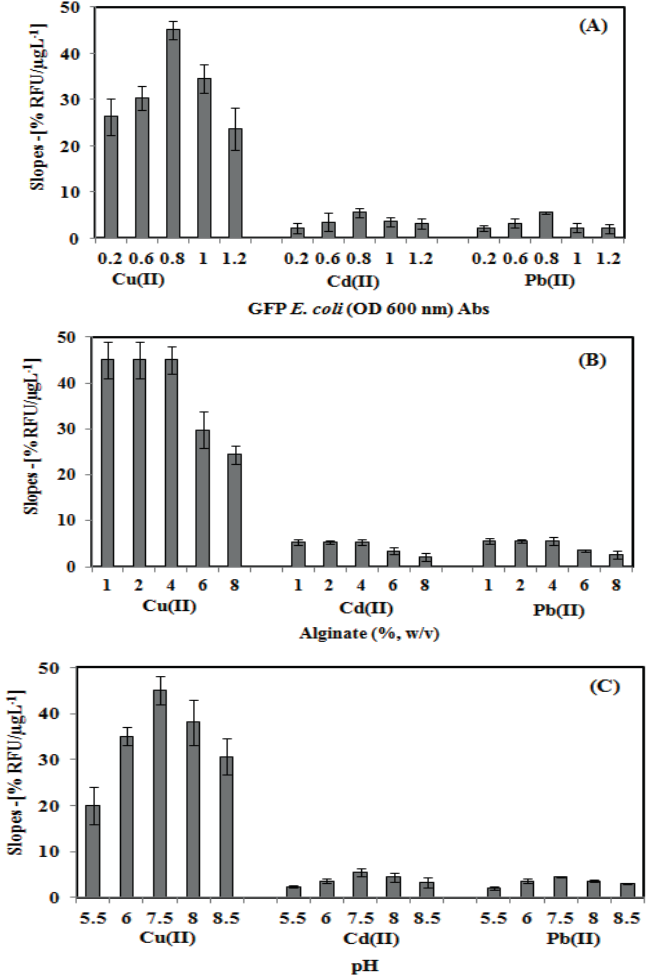
Figure 3. Effect of GFP E. coli cell loading ( A ), alginate concentration ( B ), and toxicants solution pH ( C ), on the microbial toxicity biosensor